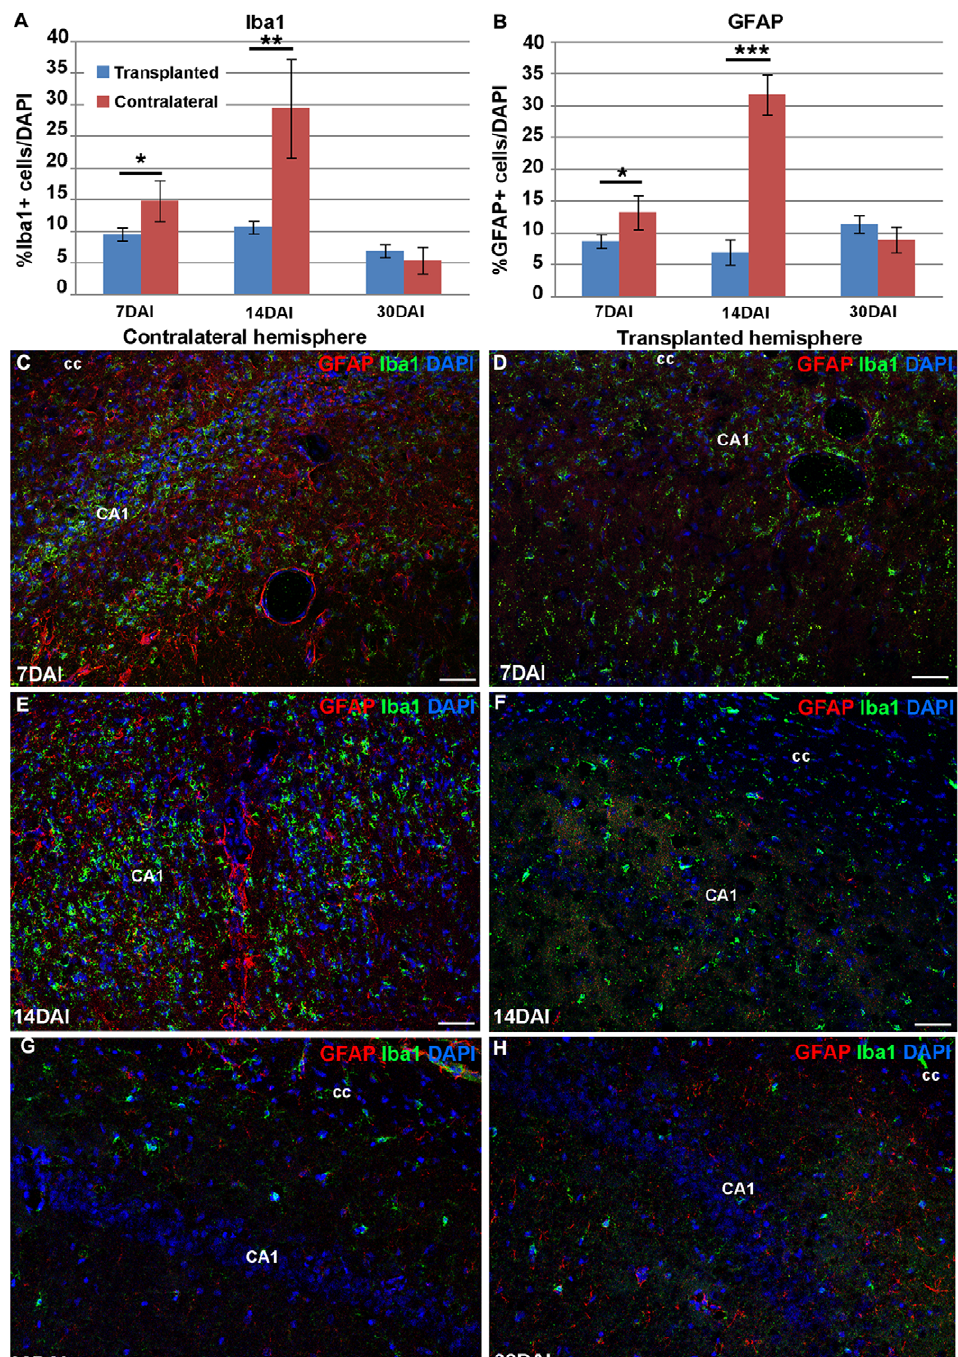
Figure 7. Effect of IhNSC-Ps on microglia and astrocyte activation. (A–B) Charts showing the effect of IhNSC-Ps transplantation on the number of microglia (Iba1 + , A) and astroglial cells (GFAP + , B) in the hippocampal region at 7, 14 and 30 DAI. (C–H) Representative images of the hippocampal regions, showing the morphology and density of Iba1 + cells (green) and GFAP + cells (red) in not transplanted (C, E, and G) and transplanted (D, F and H) brain hemispheres at 7, 14 and 30 DAI. Abbreviations: cc = corpus callosum. Scale bars: 50 m m.